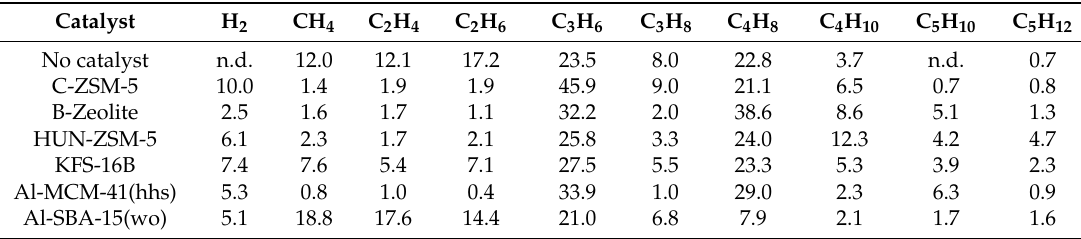
Table 4. Composition of the pyrolysis gas products